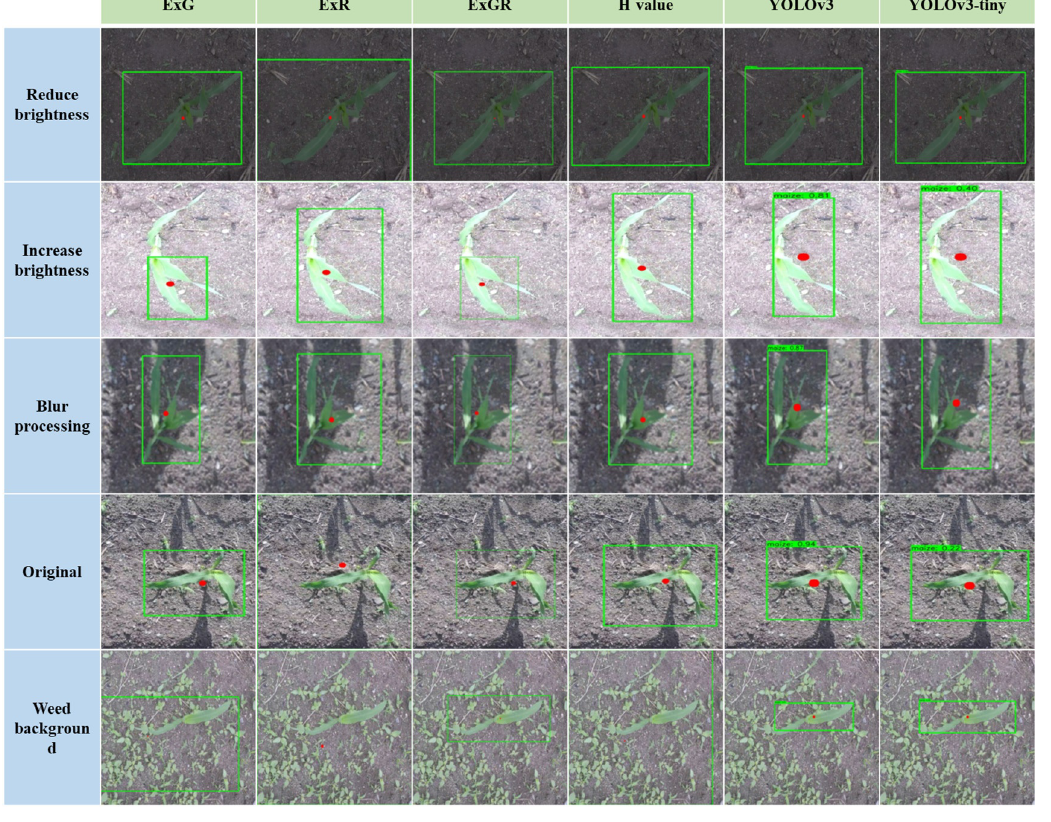
Figure 16. Several samples of detection results.